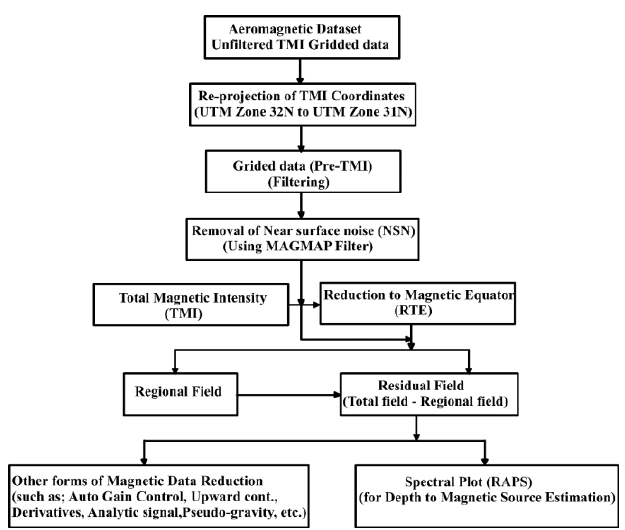
Figure 2: Data Processing Flow